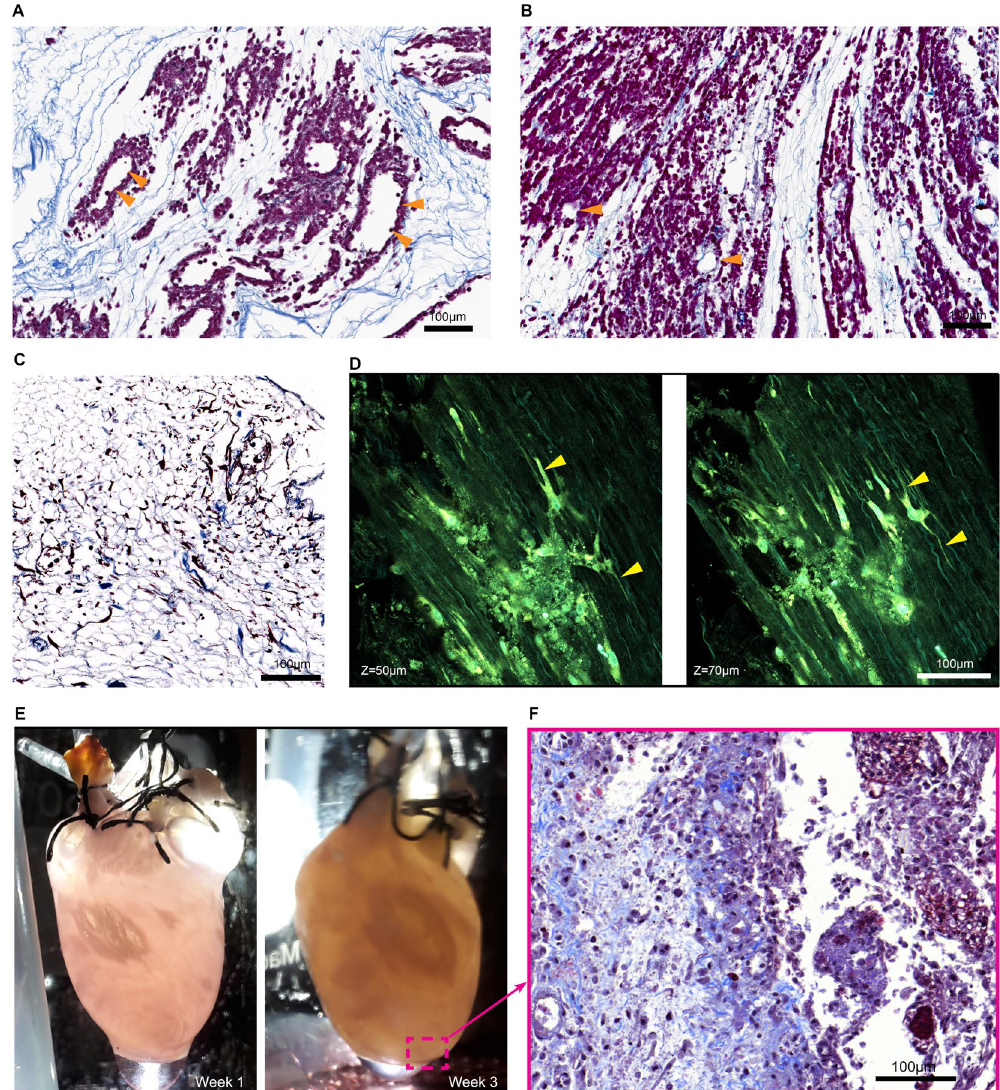
Figure 3. Perfusion recellularization of HEK293 cells, fibroblasts, and h-iPS-CPCs into 4-Flow cannulated hearts. ( A ) HEK293 cells delivered through only the SV of a 4-Flow heart perfuse through the cardiac veins and throughout the walls of the heart and distribute within the matrix proximal to the vasculature maintaining a hollow lumen (n = 3). ( B ) HEK293 cells delivered through both SV to the cardiac vein and AA to the coronary arteries are more thoroughly dispersed into the tissue walls leaving the vasculature hollow (orange triangles) (n = 3). ( C ) Perfusion culture of a primary human cardiac fibroblasts repopulated 4-Flow heart demonstrates cell survival, attachment, and invasion into the tissue (n = 3). Multiphoton imaging captures collagen fiber structures through second harmonic generation seen in cyan while autofluorescence of elastin and cells, and Hoechst nuclear staining is shown in green-yellow. ( D ) Multiphoton imaging of the 2-week 4-Flow heart reveals the lamellipodia extensions of the fibroblasts (yellow triangles) interacting with the decellularized matrix in three-dimension (n = 3). ( E ) Macroscopic observation of the recellularized heart with h-iPS-CPCs during the 3 weeks of culture indicate change in opacity (n = 3). ( F ) Corresponding representative image of Masson’s Trichrome staining shows cells are embedded within the collagen matrix. Histology sections were stained with Masson’s trichrome in which cell nuclei are purple and collagen fibers are